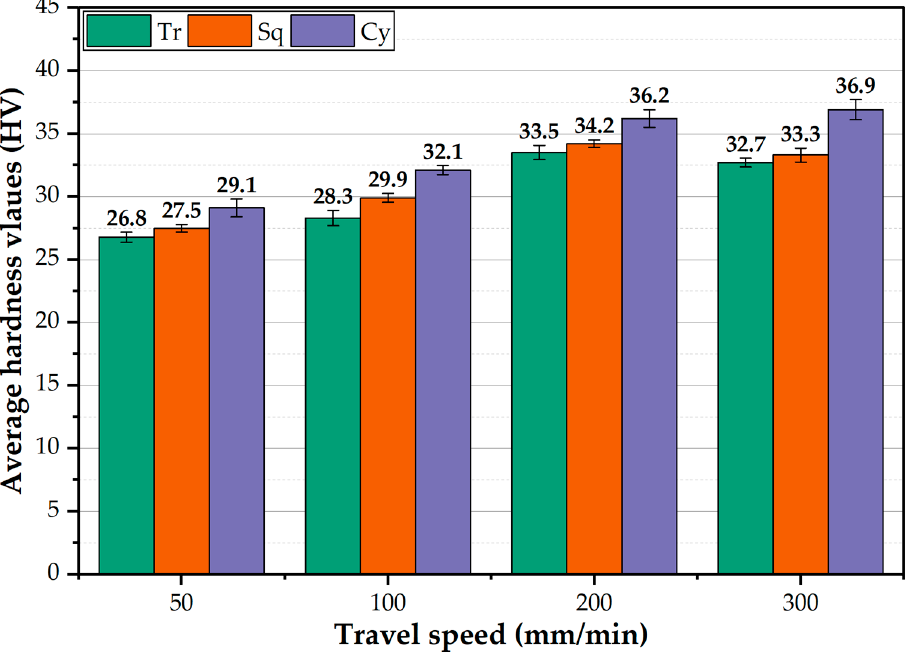
Figure 17. The AA1050 PZ average hardness values using the Tr, Sq, and Cy pin geometries at the applied travel speeds from 50 to 300 mm/min and a constant rotation speed of 600 rpm.